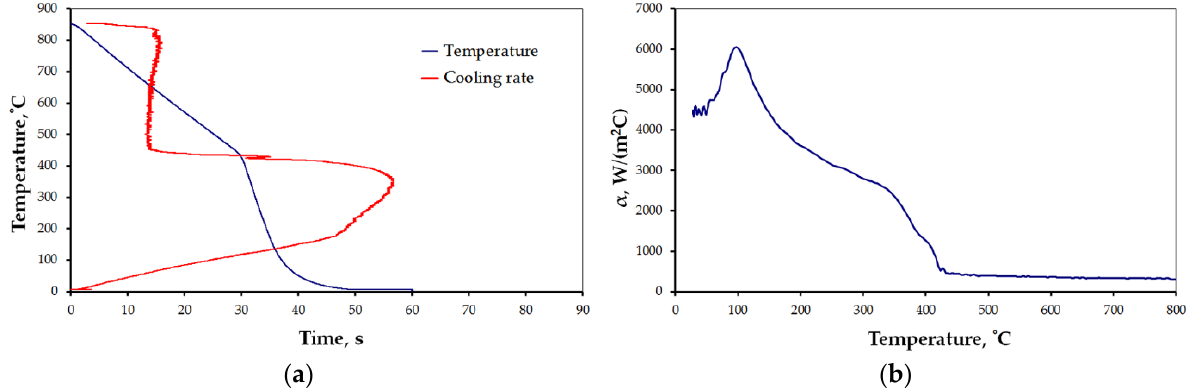
Figure 9. Results of measurement: ( a ) T = f( τ ) and v = f(T) , and ( b ) heat transfer coefficient for settings 4 (Table 1).